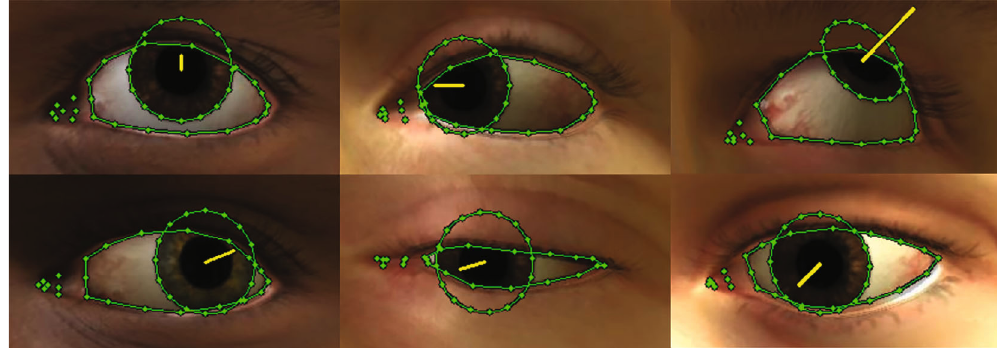
Figure 3: Synthetic eye images from UnityEyes with rich